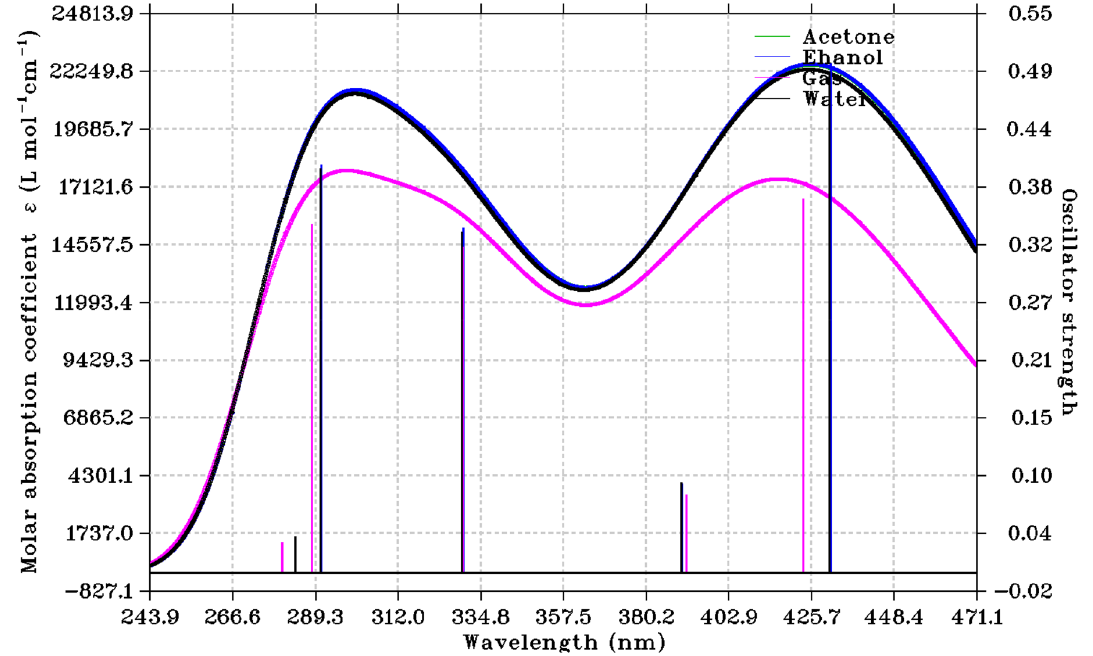
Fig. 7 Simulated UV-vis spectra of the studied compound calculated with B3LYP/6-31G(d,p) basis